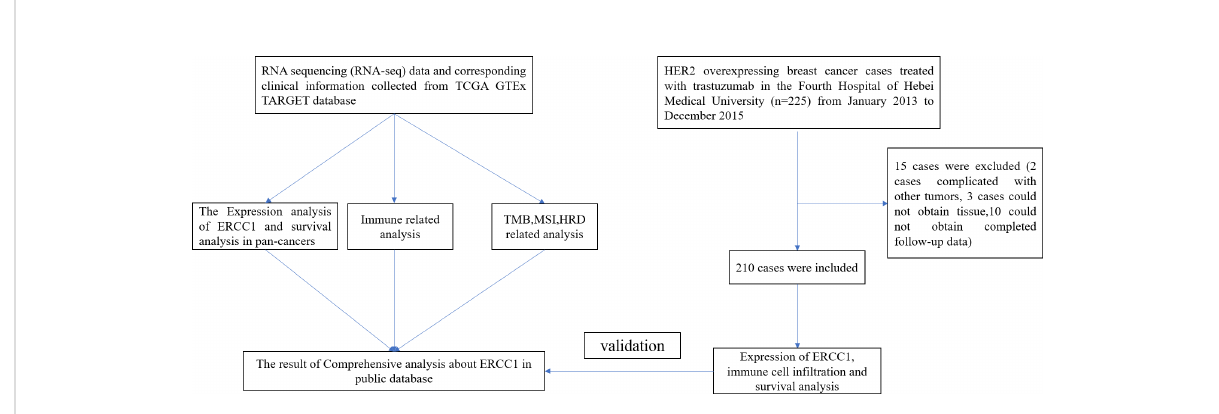
FIGURE 1 The fl owchart of the complete data analysis and validation of ERCC1